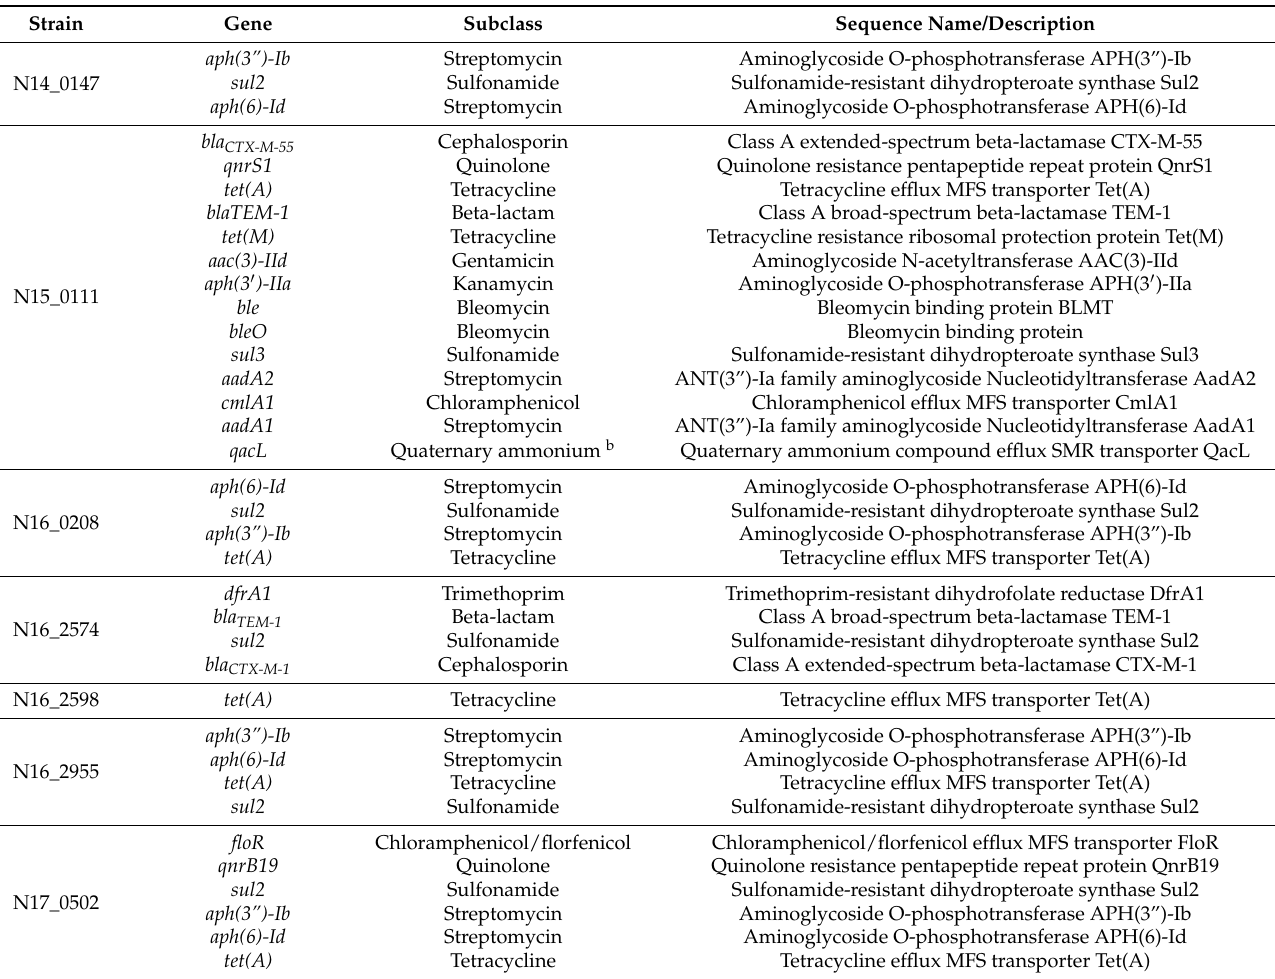
a Galaxy GenomeTrakr AMRFinder tool used for identification of antimicrobial resistance (AMR). All FASTA genomes of 98 S. Bovismorbificans were scanned, and 7 strains captured the acquired antimicrobial resistance genes. b Element type: Stress; Element subtype: Biocide.